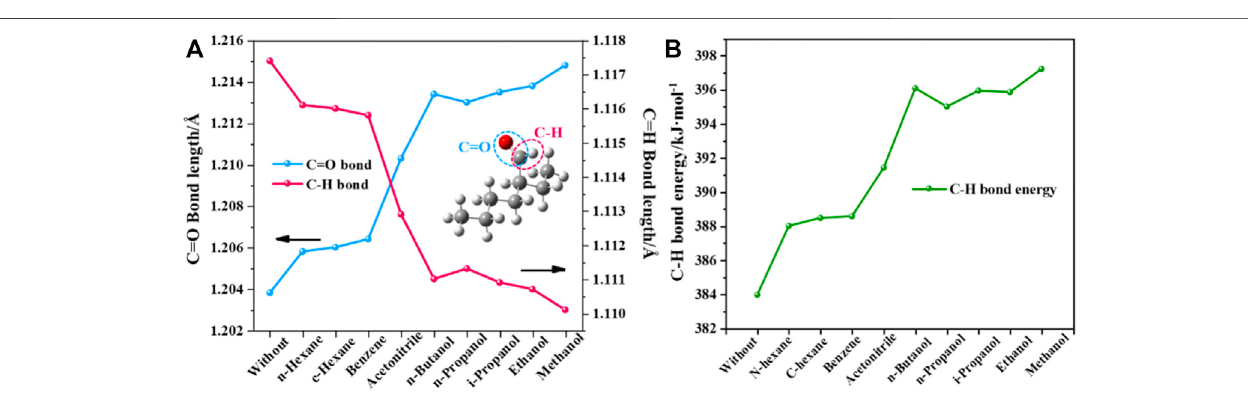
Frontiers in Chemistry |